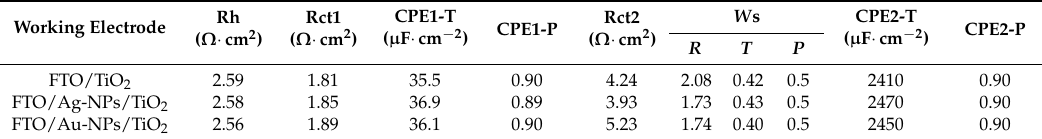
Table 2. Impedance parameters of three DSCs with FTO/TiO 2 , FTO/Ag-NPs/TiO 2 and FTO/Au-NPs/ TiO 2 working electrodes (WEs), as estimated from the impedance spectra and equivalent circuit shown in Figure 3a. Rh: Ohmic internal resistance; Rct1: charge-transfer resistance at counter electrode/electrolyte interface; Rct2: charge-transfer resistance at working electrode/electrolyte interface; W1: Warburg impedance; CPE1: the constant phase element at counter electrode/electrolyte interface; CPE2: the constant phase element at working electrode/electrolyte interface. Note that CPE = (CPE-T) ´ 1 ( jw ) ´ (CPE-P) , in which j 2 = ´ 1, w = frequency, CPE-T and CPE-P are frequency- independent parameters of the CPE. W s = R ˆ tanh([ j ˆ T ˆ w ] P )/( j ˆ T ˆ w ) P , where R is real part of impedance; T is the diffusion interpretation of Warburg element and it is given by T = L 2 / D in which L is effective diffusion thickness and D is diffusion coefficient of particles; P =